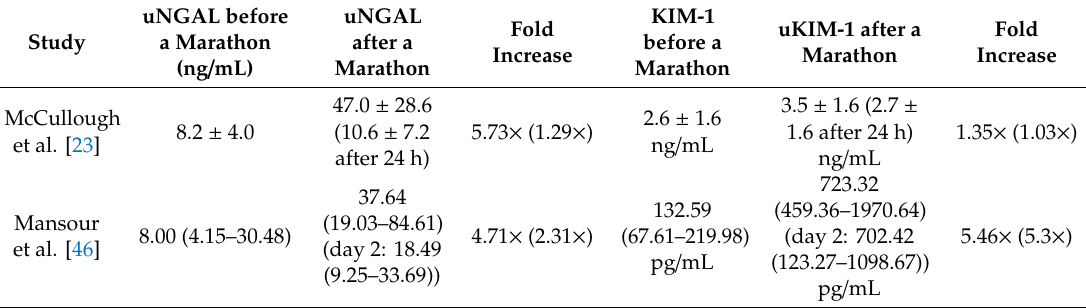
Table 3. Changes in uNGAL and uKIM-1 after a